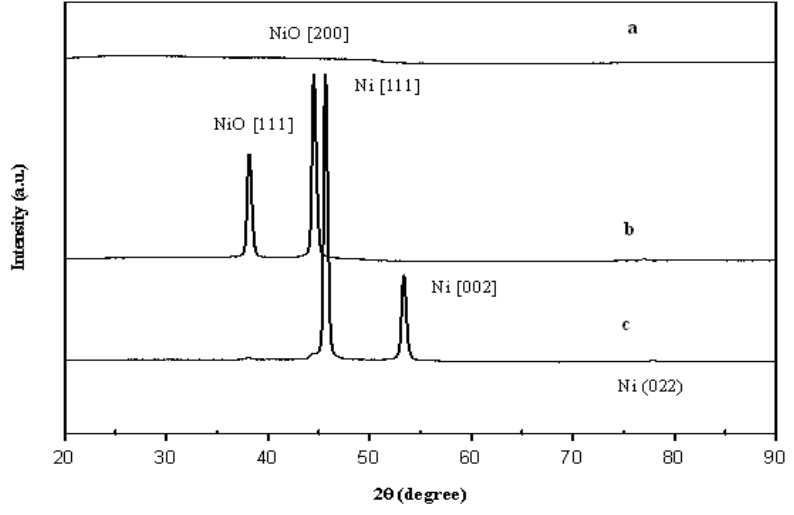
Figure 10. Wide-angle x-ray diffractometer (WAXD) diffraction patterns of: PVP/Ni acetate nanofibers ( a ), NiO nanofibers ( b ), and Ni nanofibers ( c ).